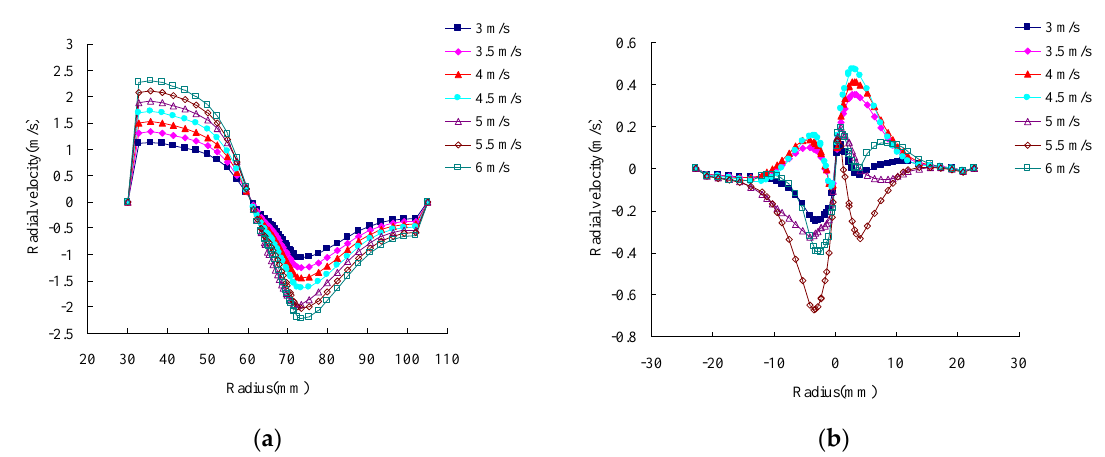
Figure 9. Radial velocity profiles: ( a ) Z = 300 mm (first stage); ( b ) Z = 150 mm (second stage).